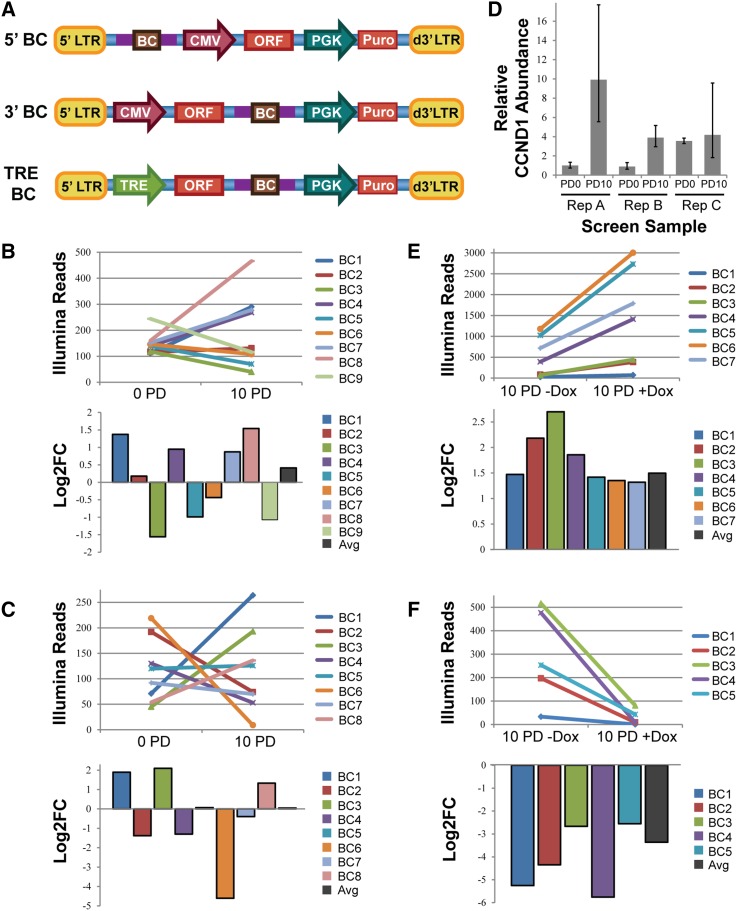
Barcode agreement in 5′ BC and TRE BC libraries. (A) Vector schematics of three library vectors constructed in the pHAGE lentiviral backbone. Note that the TRE BC Library was used in cells that had previously been transduced with a lentivirus carrying the reverse tetracycline transactivator (rtTA). LTR, long terminal repeat; BC, barcode; CMV, cytomegalovirus immediate-early promoter; PGK, phosphoglycerate kinase 1 promoter; TRE, tetracycline responsive element promoter. (B, C) Distribution of normalized read counts in initial (0 PD) and final (10 PD) screen samples (top panel) and Log2FC (bottom panel) for a representative set of BCs mapped to CCND1 (B) or CDKN1A (C) in the 5′BC library. (D) RT-qPCR measurement of CCND1 abundance in gDNA from three replicates measured at initial (PD0) and final (PD10) time points of the 5′BC library screen. Assays were performed in triplicate (error bars ± SD). (E, F) Distribution of normalized read counts in initial (10 PD –Dox) and final (10 PD +Dox) screen samples (top panel) and Log2FC (bottom panel) for a representative set of BCs mapped to CCND1 (E) or CDKN1A (F) in the TRE BC library.